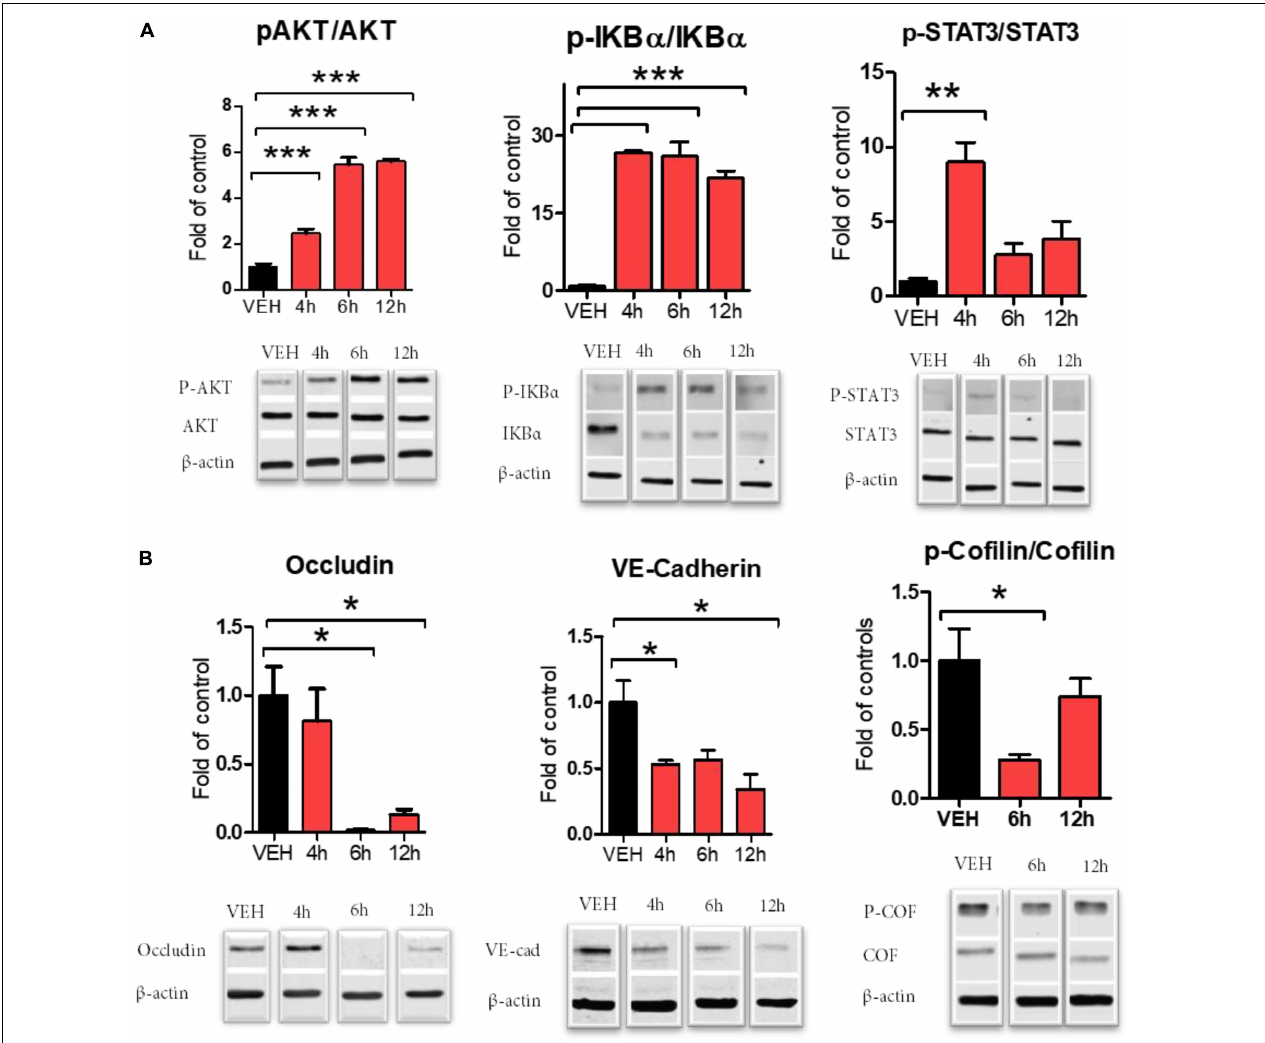
FIGURE 2 | Activation of HLMVEC exposed to 20 nM of S1SP for 4–12 h. (A) Western blot analysis of AKT, IKB α , and-STAT3 phosphorylation; (B) cofilin phosphorylation and expression of occludin and VE-cadherin. Activated proteins are expressed as the ratio of phosphorylated to total protein. Data represent means ± SEM; n = 3–4; * p < 0.05; ** p < 0.01; *** p < 0.001 between groups, 1-way ANOVA and Tukey’s post hoc